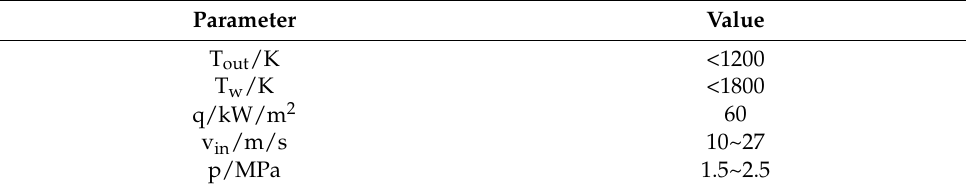
Figure 19. Physical model for numerical simulation of Chen et al. [19].